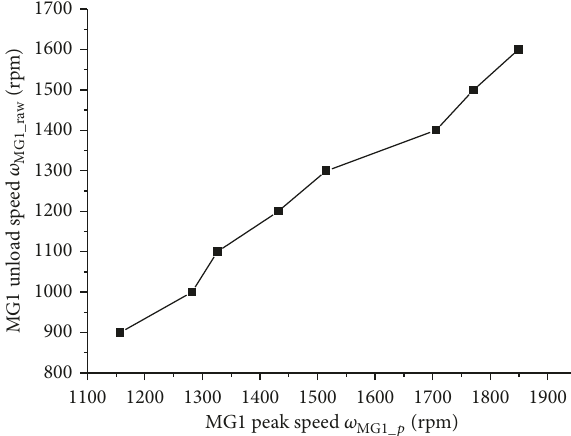
Figure 13: The peak speed 𝜔 𝑝 MG 1 with unload speed 𝜔 raw MG 1 .